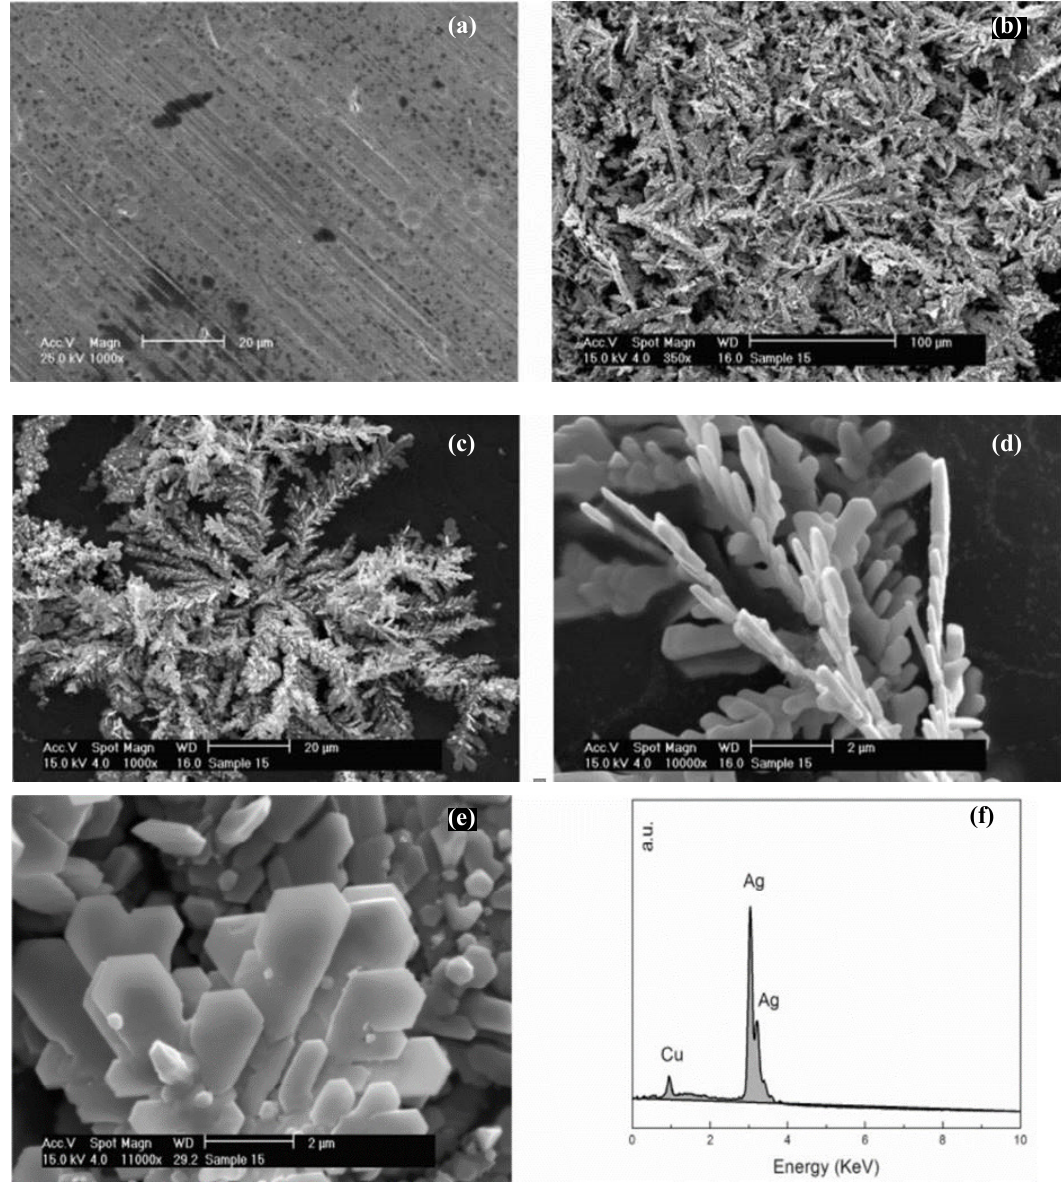
Fig. 10: SEM images of (a) surface of the Cu foil, (b,c) leaflike silver microstructures formed on the Cu surface, (d,e) as for (c) taken from different areas under a higher magnification, and (f) EDX spectrum of the silver nanoclusters. Reproduced with permission from ref.42, copyright 2005, American Chemical